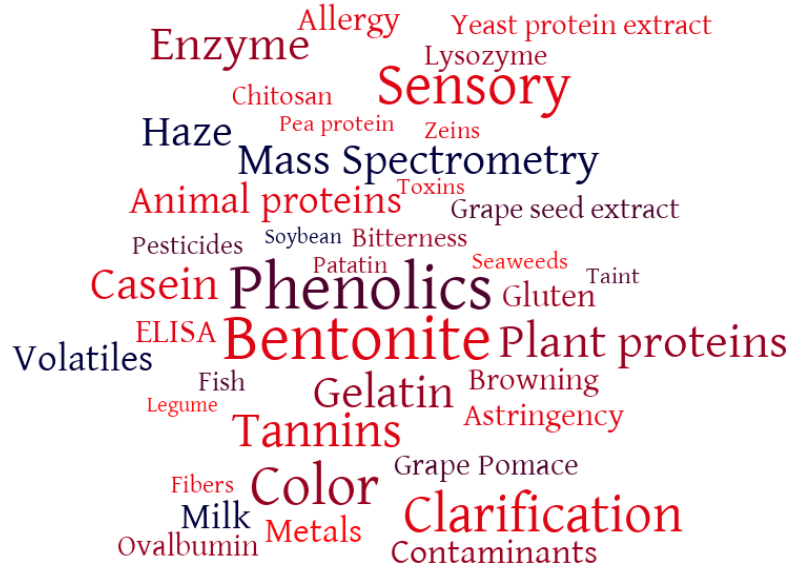
Figure 1. Wordcloud representation of the main key words occurrences in publications found during a Scopus search executed on the 26th of February 2019 (n = 302, publication range 1905–2019). Created with worditout.com. The total number of mentions was 2273, with each word mentioned as follows (number of occurrences enclosed in parentheses): Phenolics (169), Bentonite (161), Sensory (140), Color (135), Clarification (122), Tannins (110), Enzyme (104), Plant proteins (102), Gelatin (97), Casein (95), Mass Spectrometry (89), Haze (86), Animal proteins (70), Volatiles (66), Milk (61), Contaminants (55), Metals (52), Gluten (50), ELISA (48), Allergy (47), Astringency (43), Browning (39), Ovalbumin (36), Grape Pomace (35), Lysozyme (31), Yeast protein extract (29), Grape seed extract (28), Chitosan (25), Fish (24), Bitterness (23), Pesticides (17), Fibers (16), Patatin (15), Zeins (12), Pea protein (9), Toxins (9), Taint (9), Seaweeds (7), Legume (4), Soybean (3).